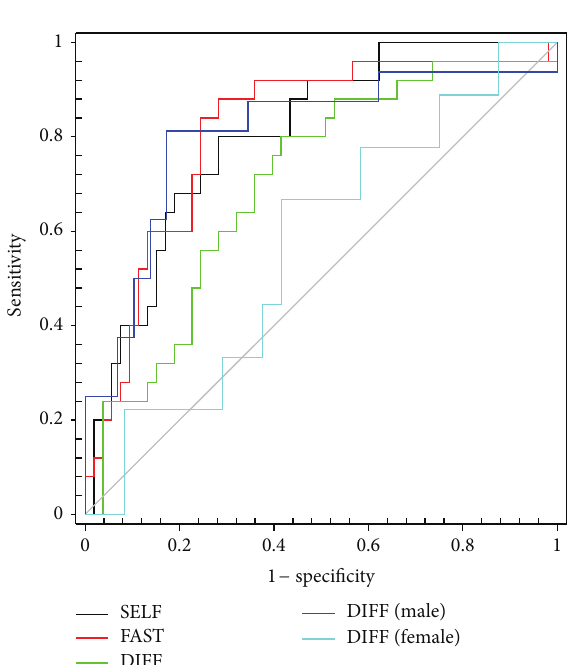
Figure 1: ROC curves for SELF (black), FAST (red), and DIFF (green) predicting fallers in the total sample. DIFF was also used to predict fallers, respectively, in men (blue) and women (cyan). SELF and FAST were strong predictors of fallers in the pooled sample. Table 5 for AUC, sensitivity, and specificity